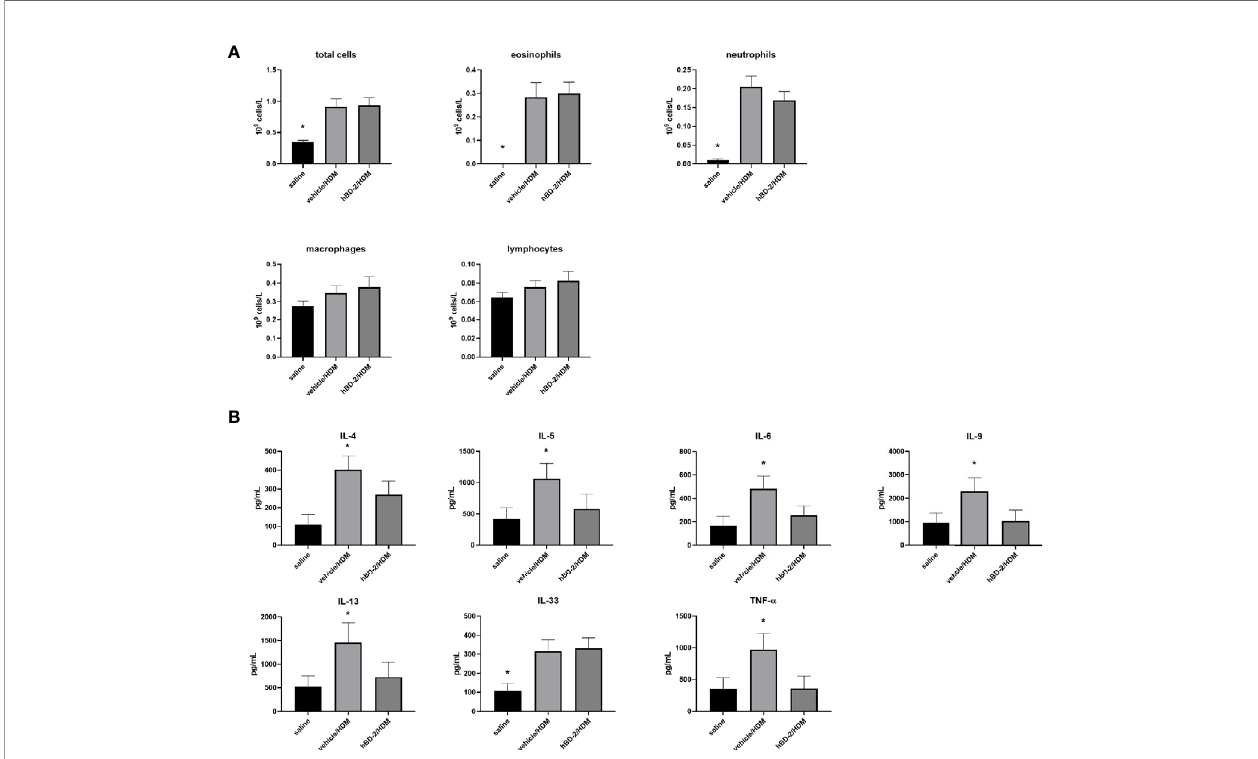
FIGURE 5 | Total and differential cell counts (eosinophils, neutrophils, macrophages, and lymphocytes) in bronchoalveolar lavage fl uid (A) and concentration of in fl ammatory cytokines (TNF a , IL-4, IL-5, IL-6, IL-9, IL-13, and IL-33) in lung homogenates of the 3 treatment groups (n=12 per group) (B) . Saline: mice sensitized with saline + CFA only (group 1). vehicle/HDM: mice sensitized with HDM at day 0, prophylactic treatment with vehicle at days 12 to 14, and challenge with HDM at day 14 (group 2). hBD-2/HDM: mice sensitized with HDM at day 0, prophylactic treatment with hBD-2 at days 12 to 14, and challenge with HDM at day 14 (group 3). *p < 0.05 when compared to other groups (ANOVA with post-hoc t-test,). hBD-2, human beta-defensin 2; HDM, house dust